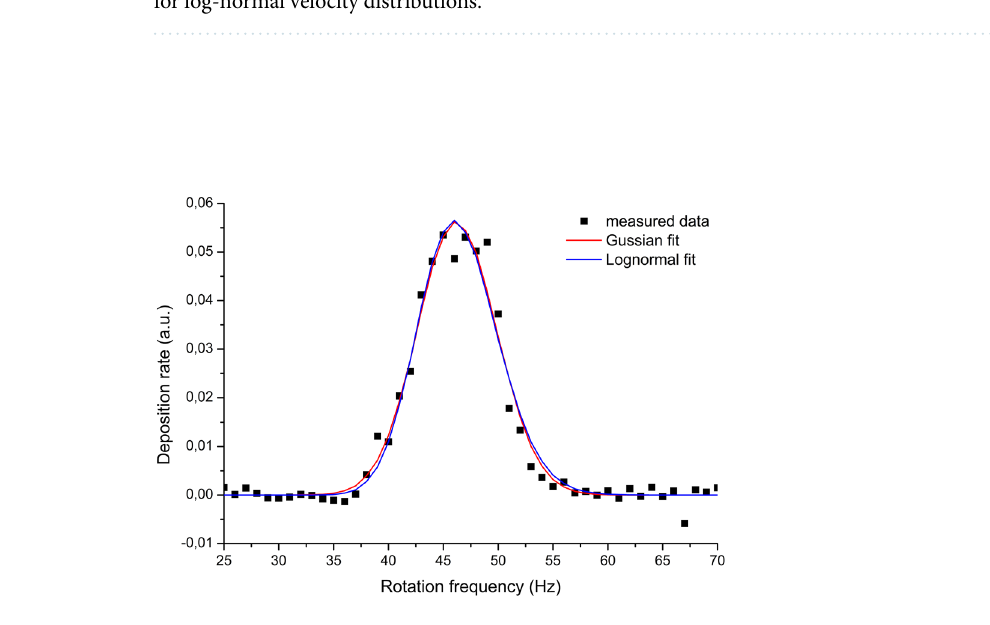
Figure 6. Comparison of fits using Gaussian (v peak = 35.05 m/s; w G = 2.624; FWHM = 6.18 m/s; RSS = 0.002813) and lognormal (v peak = 35.08 m/s; w L = 0.074; FWHM = 6.09 m/s; RSS = 0.002871) distributions of nanoparticle velocities. Nanoparticles have been deposited at aggregation chamber pressure 20 Pa, deposition chamber pressure 0.015 Pa, DC magnetron current 200 mA and QCM averaging over 20